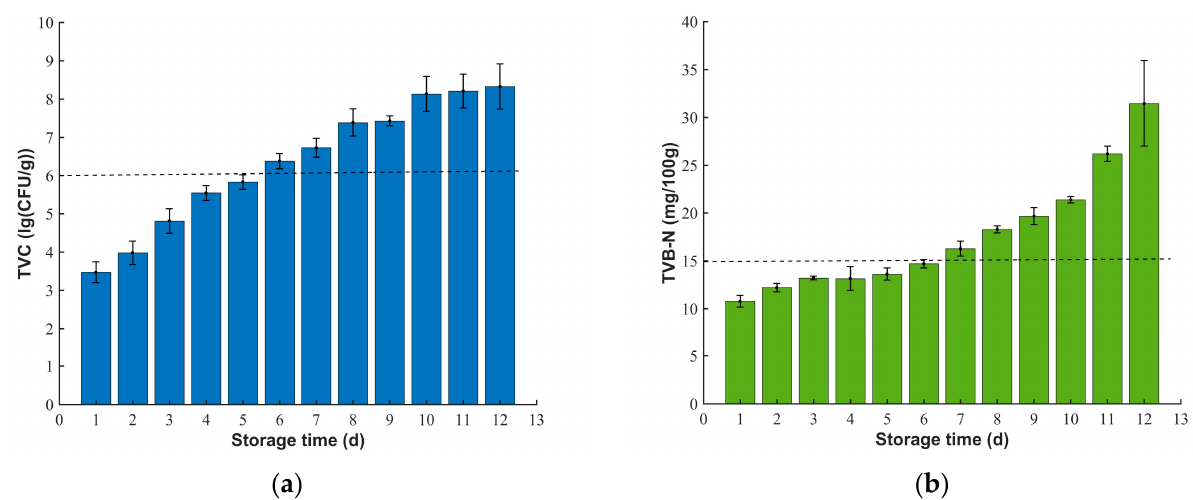
Figure 3. Changes in the mean values of pork freshness indicators during storage. ( a ) TVC; ( b ) TVB-N. (Standard error bars are provided, with each bar representing the mean ± standard deviation.) Table 1. Class assignments of pork and their distributions in calibration and prediction